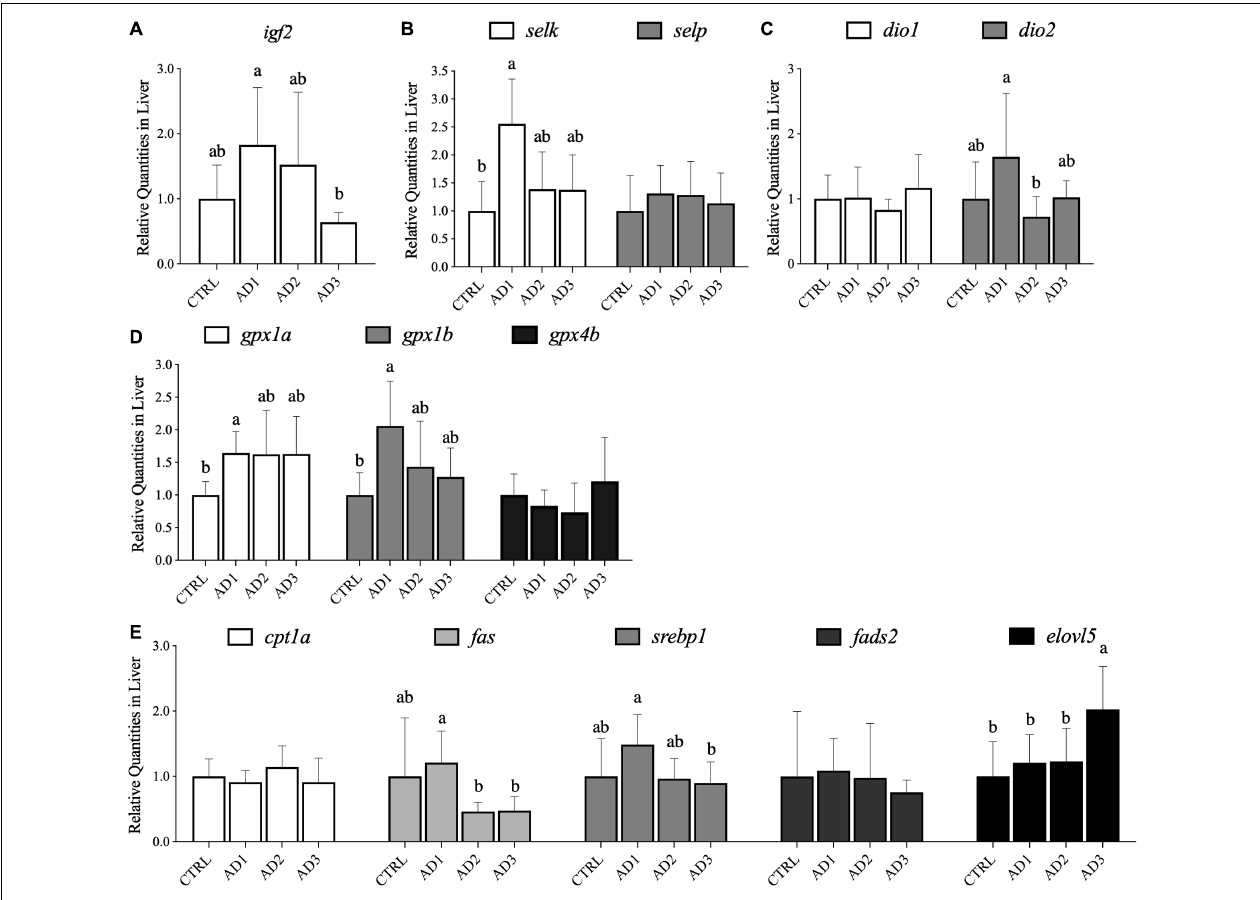
FIGURE 2 | Gene expression in the liver of gilthead seabream fed the experimental diets over 12 weeks. (A) Genes growth-related; (B) genes involved in selenium metabolism; (C) genes involved in iodine metabolism; (D) genes associated with oxidative stress; (E) genes involved in lipid metabolism (lipolytic, lipogenic, desaturation, and elongation pathway related gene). Relative abundance in liver is presented as mean ± SD ( n = 9 fish per treatment). Different letters denote significant differences among treatments.